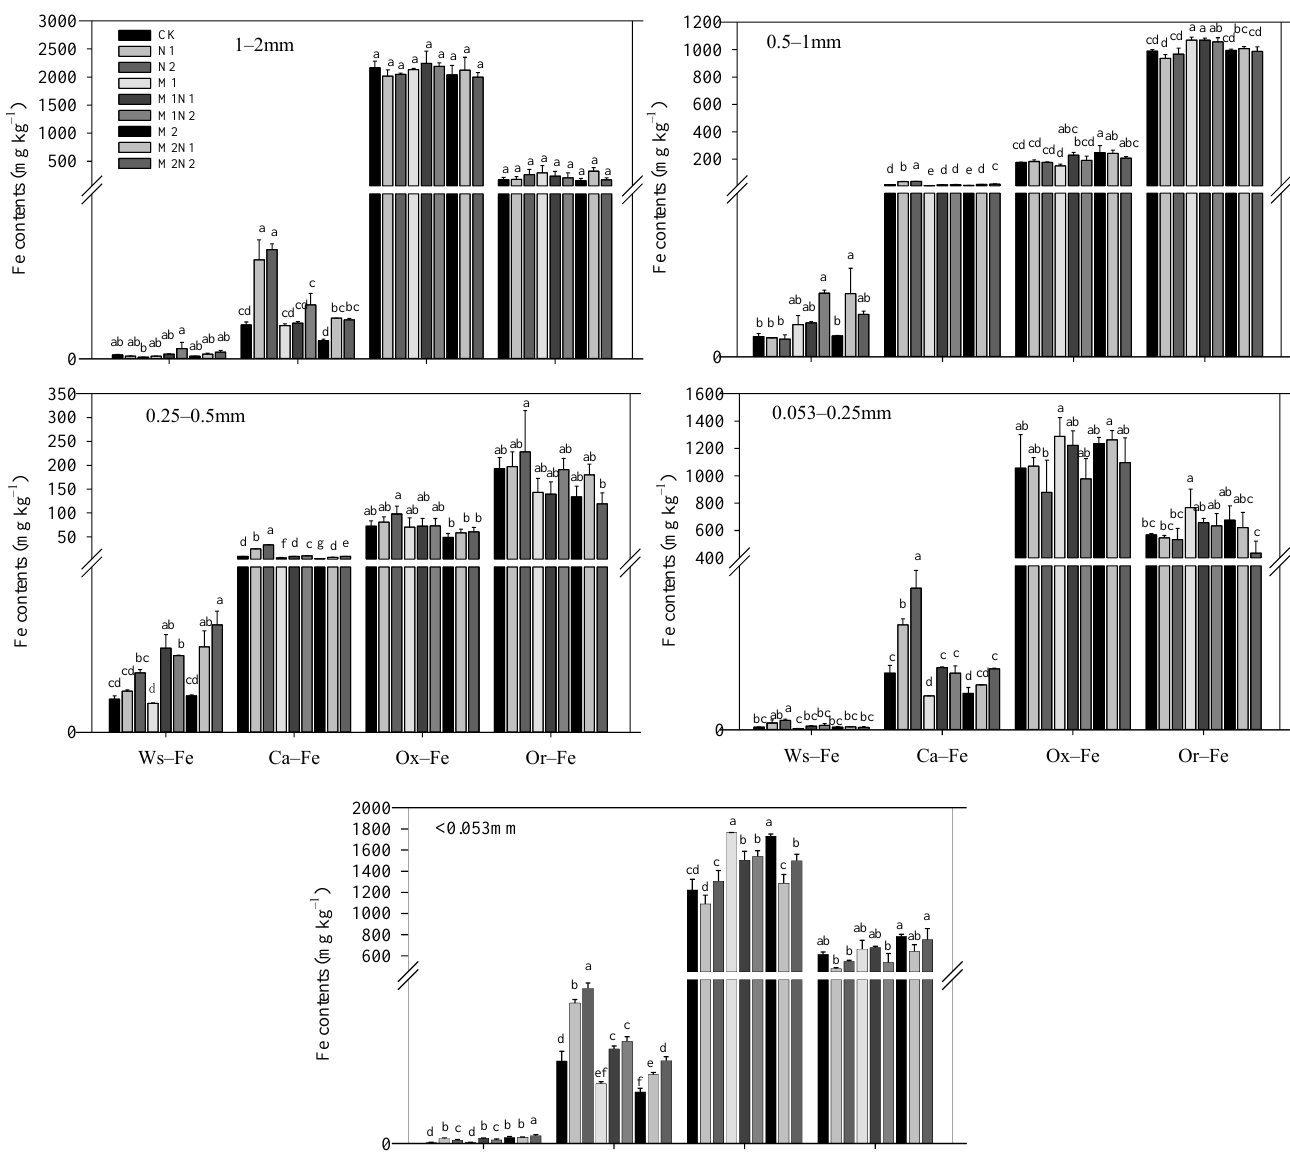
Figure 3. Contents of continuous–extraction Fe in soil aggregates after 38–year fertilization with nine treatments. CK: no fertilizer, N1: low nitrogen, N2: high nitrogen, M1: low manure, M1N1: low manure and low nitrogen, M1N2: low manure and high nitrogen, M2: high manure, M2N1: high manure and low nitrogen, M2N2: high manure and high nitrogen. Ws–Fe: water–soluble Fe, Ca–Fe: carbonate–bound Fe, Ox–Fe: iron–manganese–oxide–bound Fe, Or–Fe: organic–matter–bound Fe. Different lower–case letters denote significant differences between treatments by least–significant difference at the 5% level.